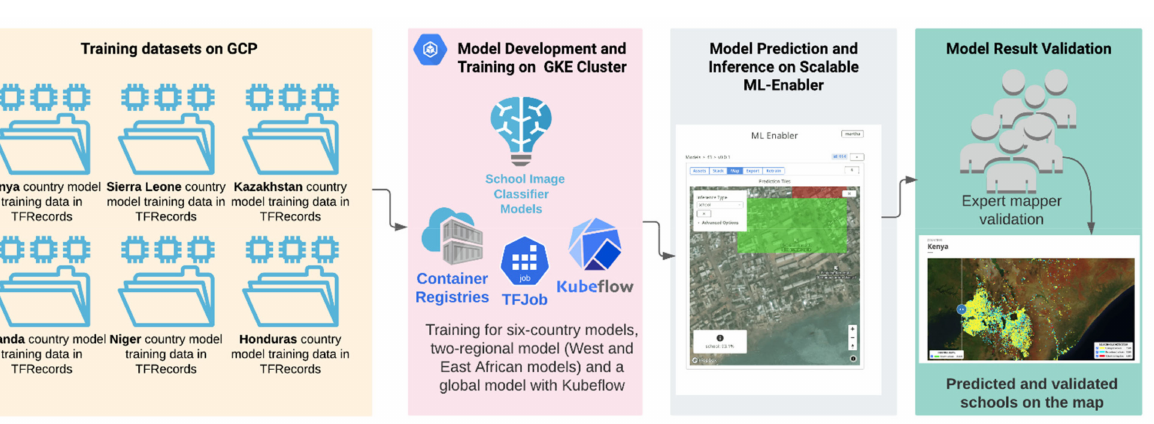
Figure 2. Model development and deployment